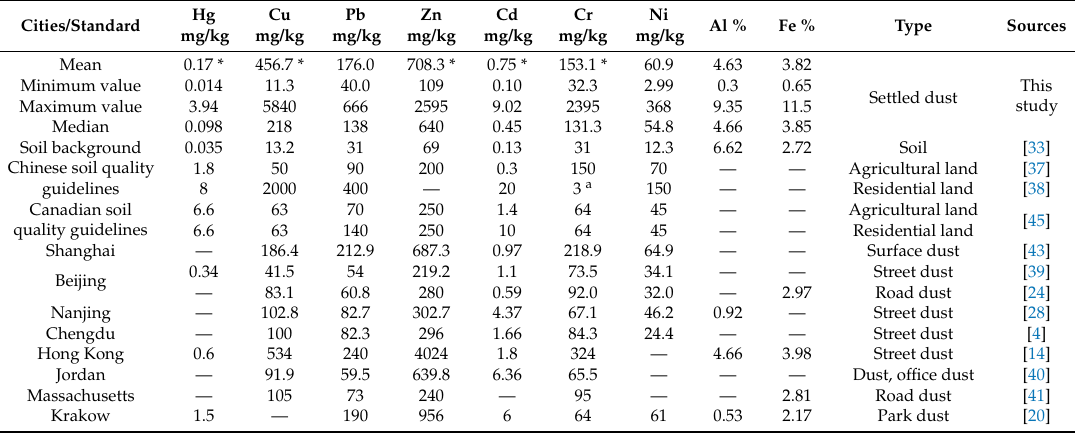
Table 2. Comparison of heavy metal contents from settled dust with the soil quality guidelines and other cities.